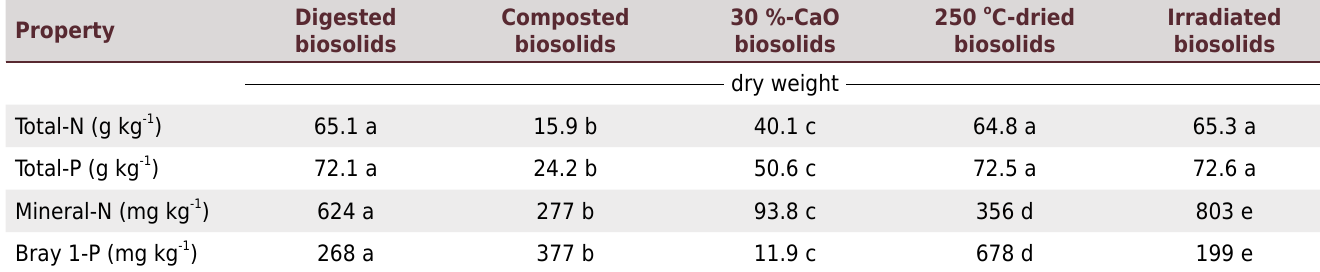
Table 1. Nitrogen and phosphorus concentrations in biosolids